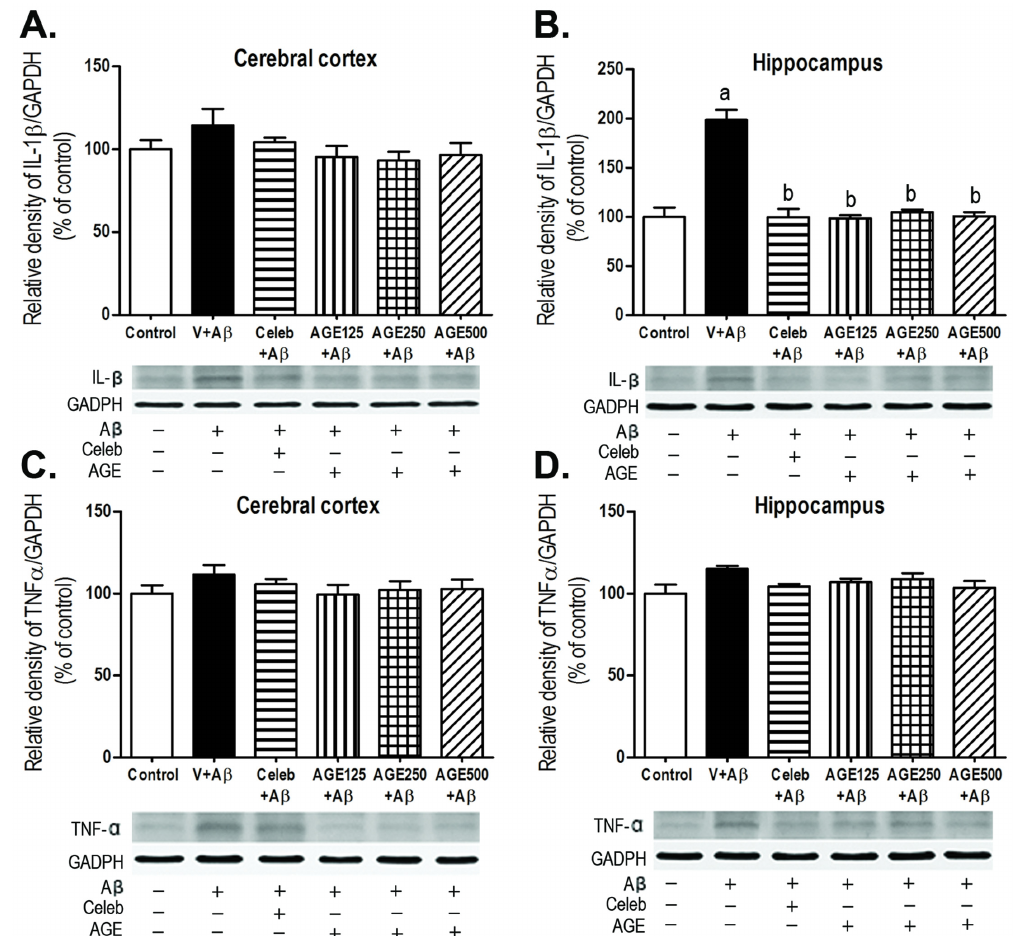
Figure 4. Effects of AGE on IL-1 β ( A , B ), and TNF α ( C , D ) densities in the rat brain. Data are presented as mean ± S.E.M. a = significant differences from control group at p < 0.001 and b = significant differences from vehicle + A β group at p < 0.001.